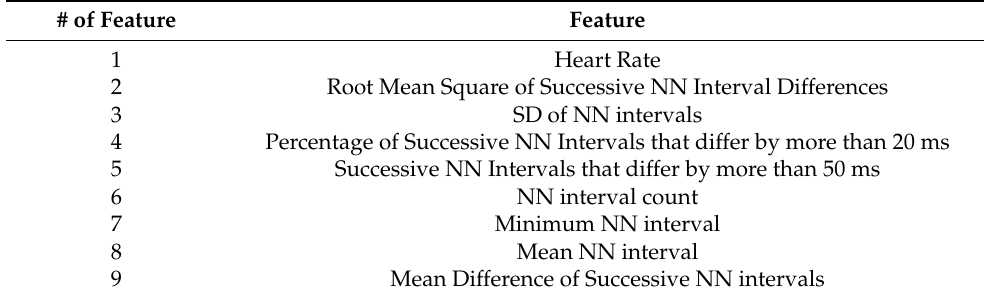
Table 6. Significant features regarding time-domain methods.